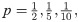
The linear function n/10, and from above to below f
p(n) for p=12,15,110, and 1100.